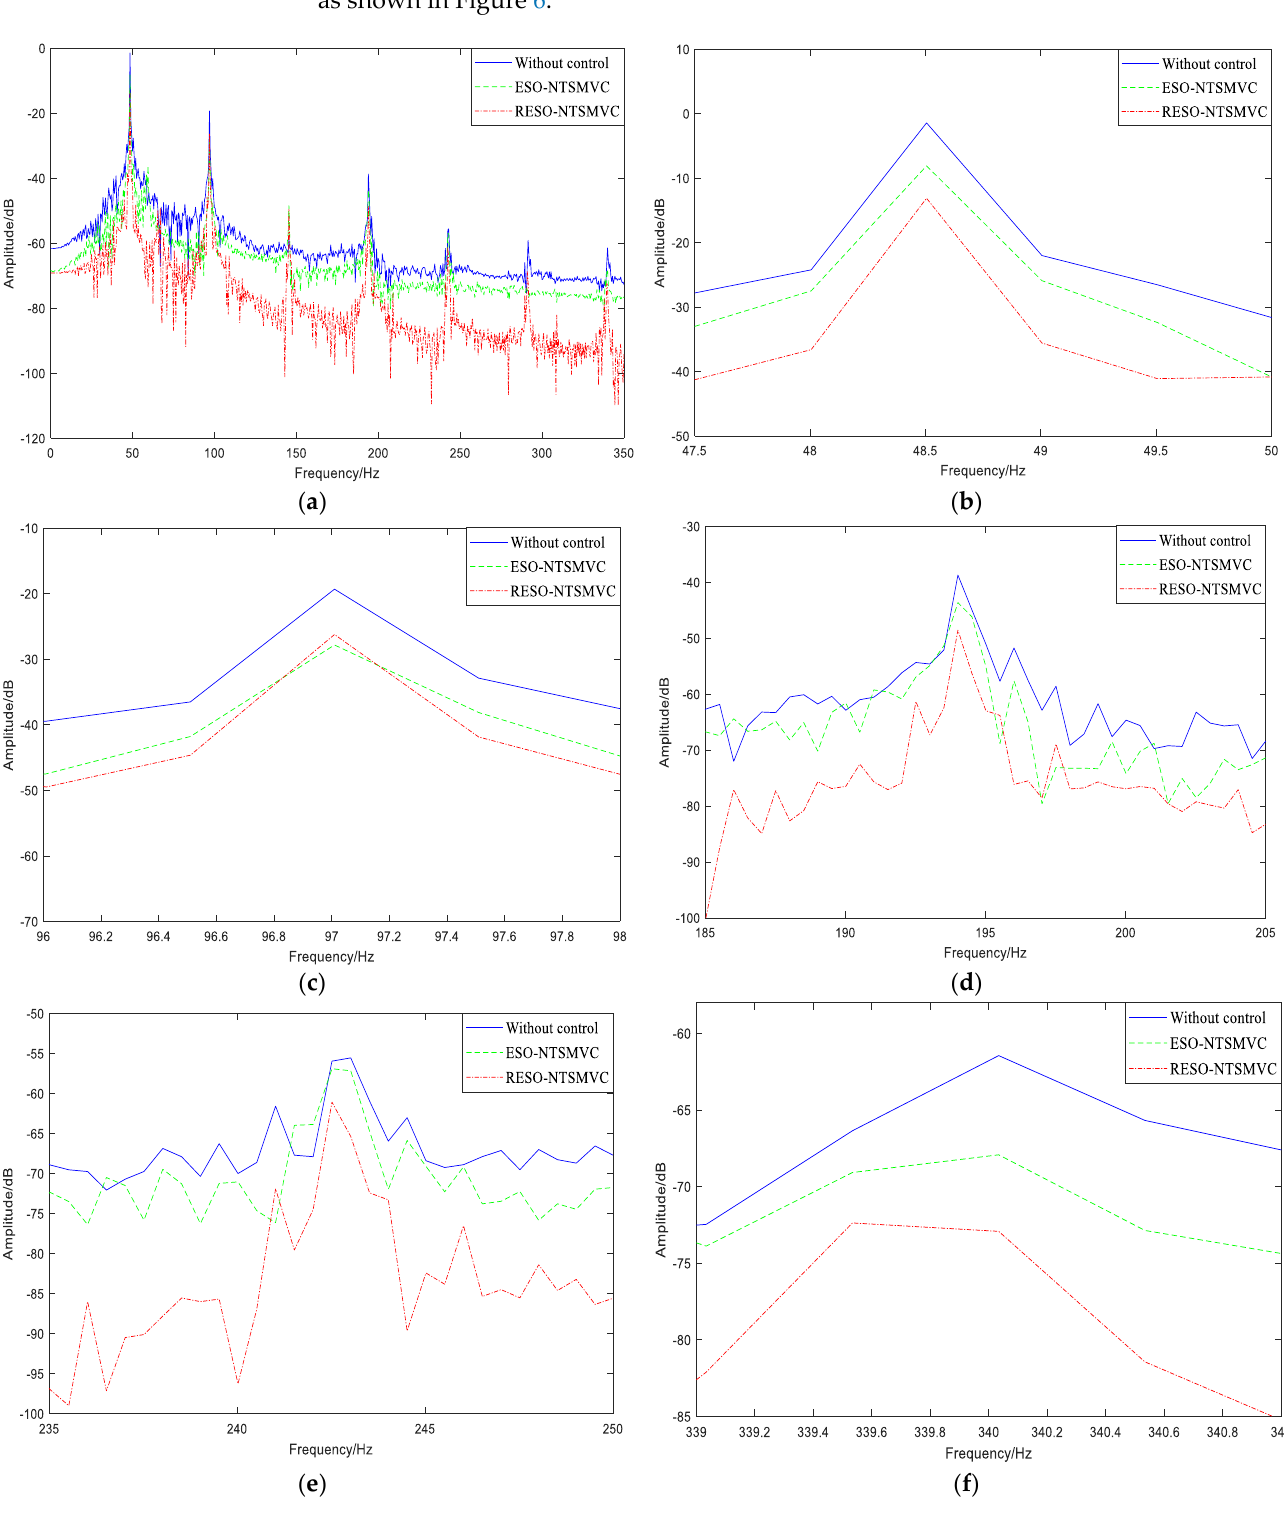
Figure 6. Frequency domain diagram: ( a ) global frequency curve; ( b ) local frequency curve near 48.5 Hz; ( c ) local frequency curve near 97 Hz; ( d ) local frequency curve near 194 Hz; ( e ) local fre‑ quency curve near 242.5 Hz; ( f ) local frequency curve near 339.5